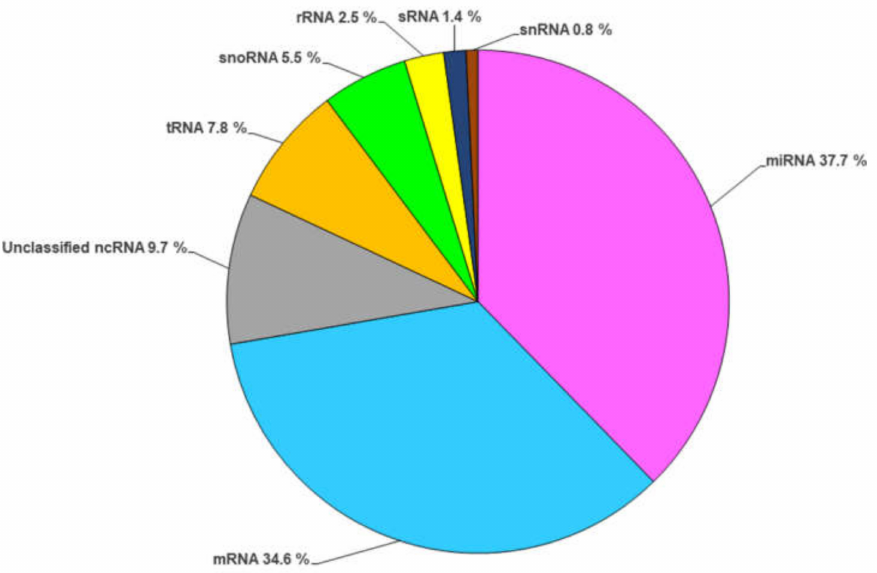
Figure 2. A compilation of data on the abundance of RNAs (%) loaded in extracellular vesicles in a set of fungal species, including C. albicans , C. neoformans , S. cerevisiae , C. auris , H. capsulatum , M. sympodialis , P. brasiliensis , and P. lutzii